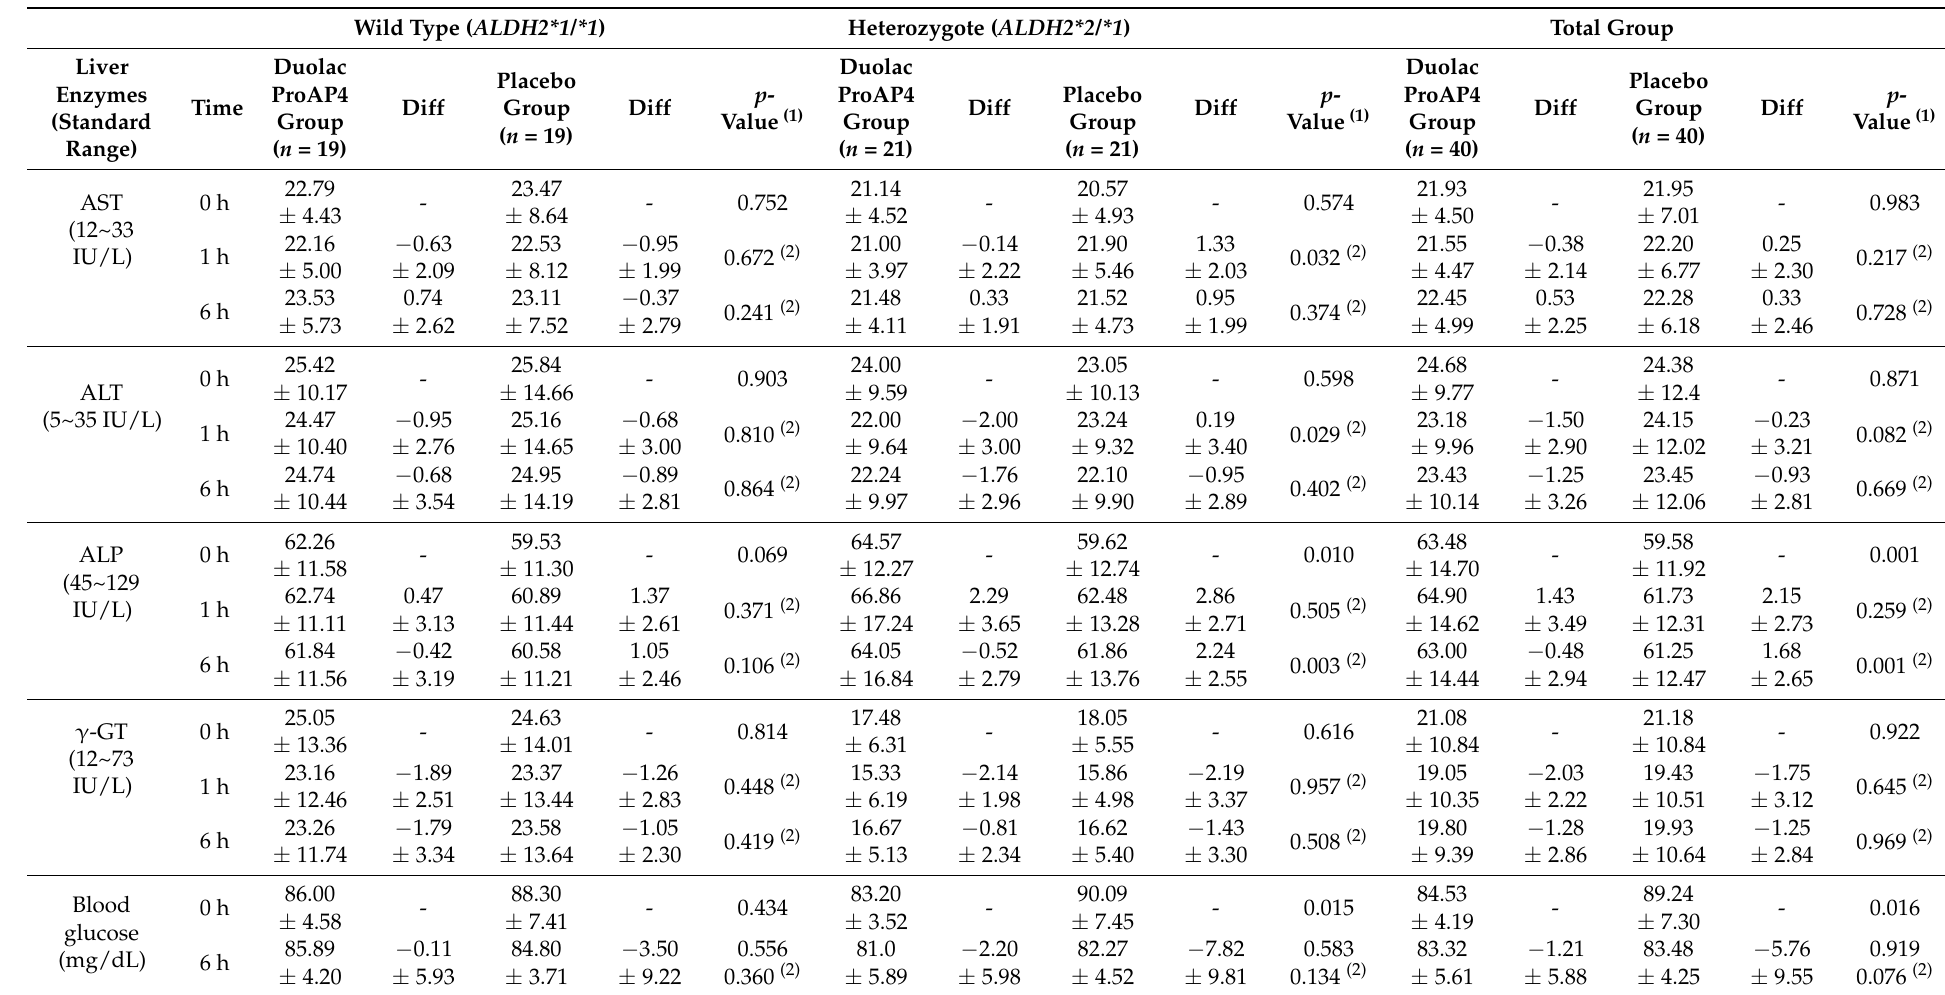
Table 4. Variation in serum liver enzymes and blood glucose levels flowing alcohol challenge test after 15 days of